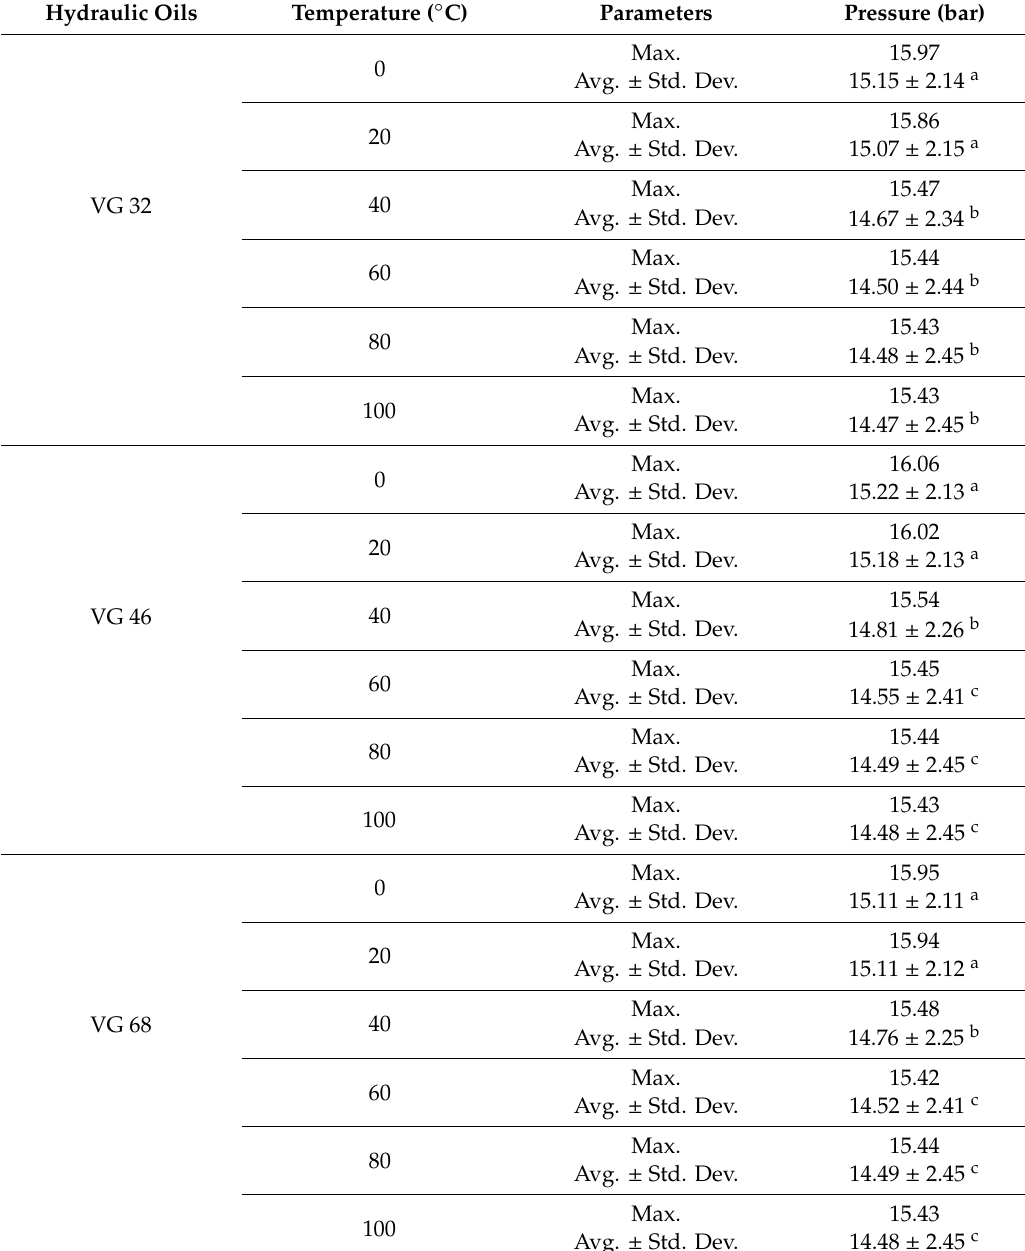
Table 3. The comparison of the proportional valve pressure at di ff erent temperatures for the PID control algorithm without considering